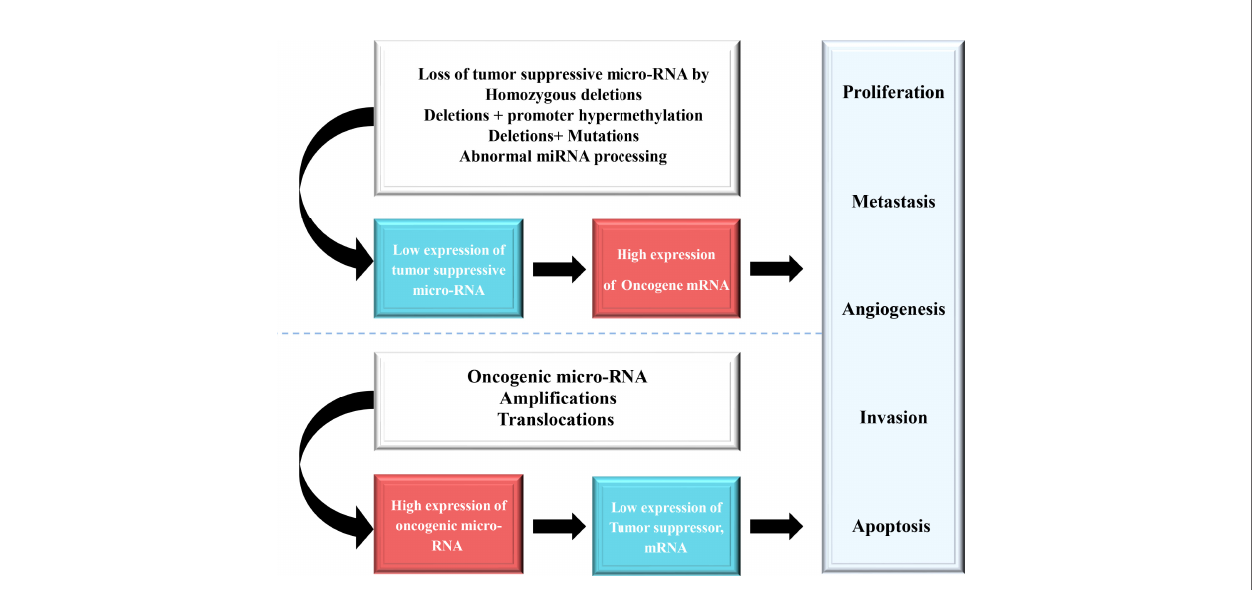
FIGURE 1 | The loss of function of tumor suppressive miRNAs result in an anomalous expression of the target tumor suppressor or oncogene, which contributes to tumor